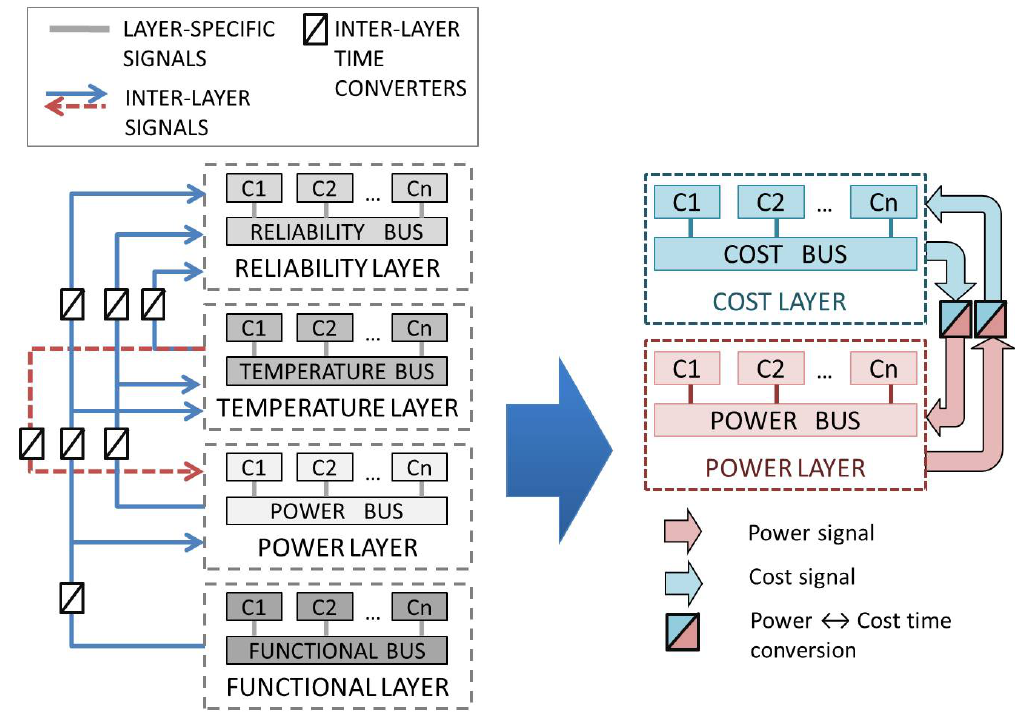
Figure 1. The multiple layered framework for the non-functional properties simulation proposed in [9] ( left ) and application to the simulation of power and cost proposed in this paper ( right